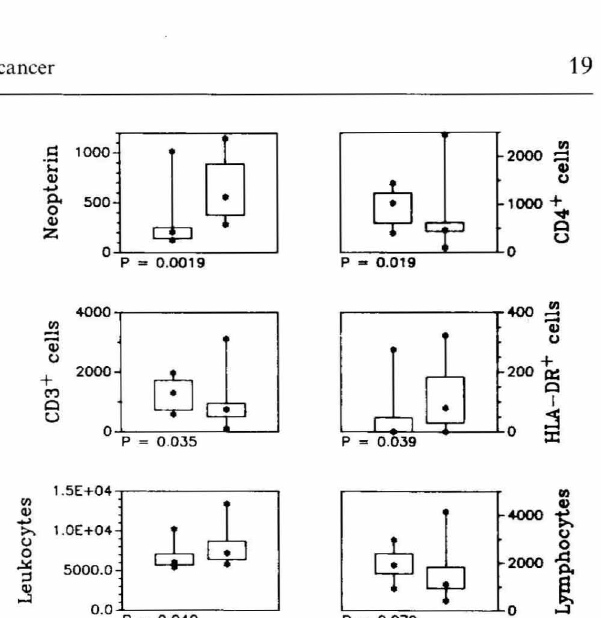
Figure 1. Box plots showing the distributions of data observed in women at first diagnosis (left box for each variable) and in women with evidence of disease during follow·up (right box for each variable). In the center of each box, the star indicates the median value, the lower and upper limits of the box denote the 25th and 75th percentiles, and the vertical lines indicate the range of obser vations. For units, see Table 1.